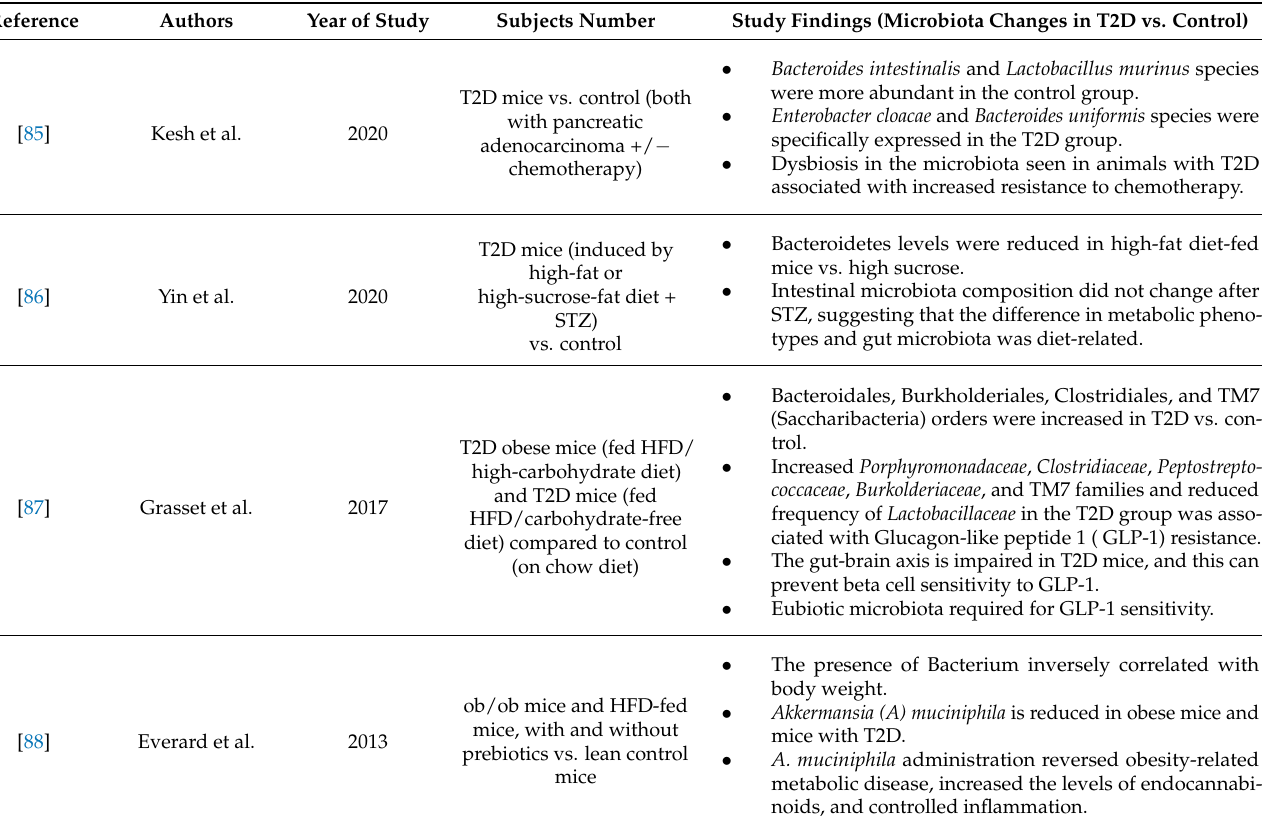
Table 3. Animal studies of the gut microbiota in